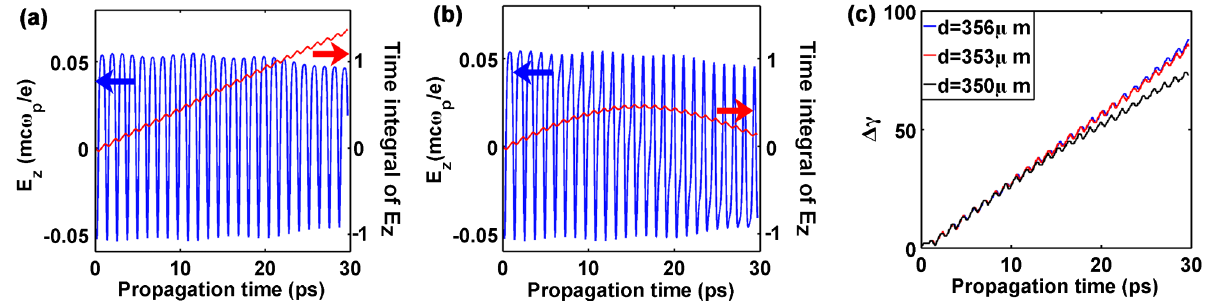
FIG. 2. On-axis longitudinal electric field (blue) and time integral of the on-axis longitudinal electric field (red) as a function of acceleration time for a fixed (cid:6) point. In (a) the modulation period matches the dephasing length, L modulation period is d ¼ 350 (cid:7) m . (c) Self-consistent energy gain as a function of acceleration for three different modulation periods: 350 (cid:7) m , 353 (cid:7) m , and 356 (cid:7) m